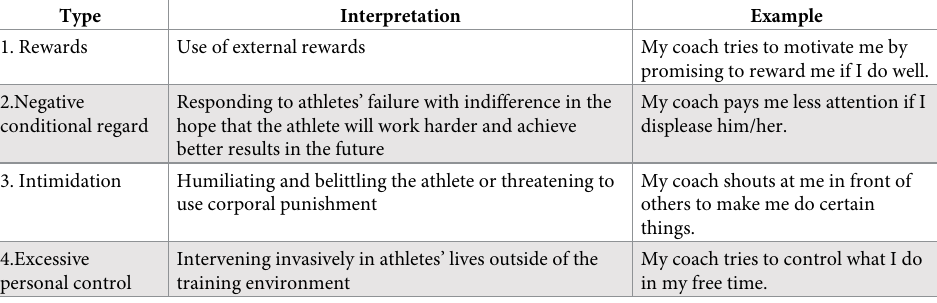
Table 1. Types of controlling coach